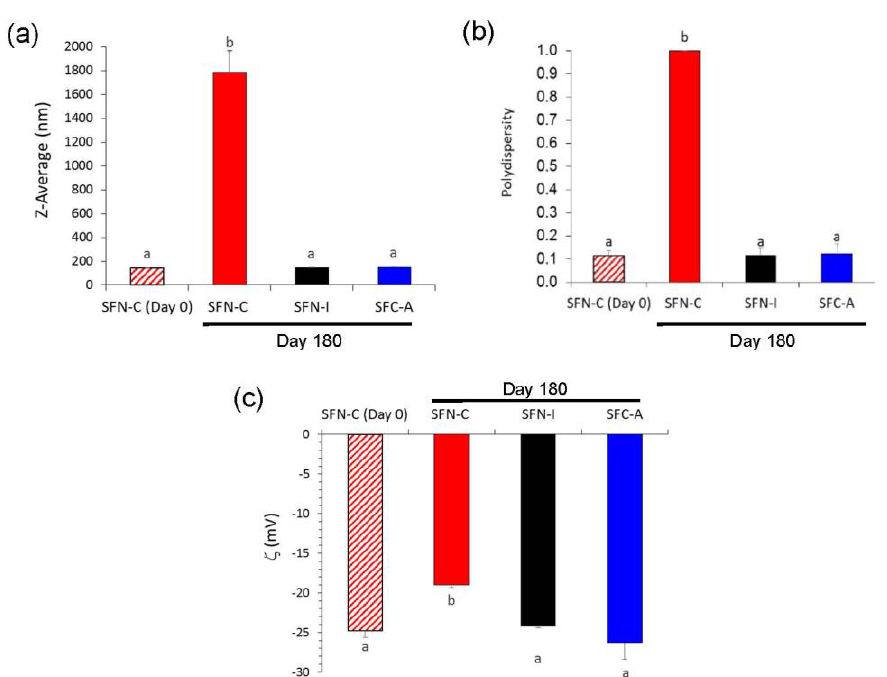
Figure 4. Effect of the time of storage on the hydrodynamic characteristics of the silk fibroin nanoparticles. ( a ) Z-average (nm); ( b ) polydispersity; ( c ) ζ (mV). Values presented as mean ± SD (N = 9). Different letters indicate significantly different values ( p < 0.05).